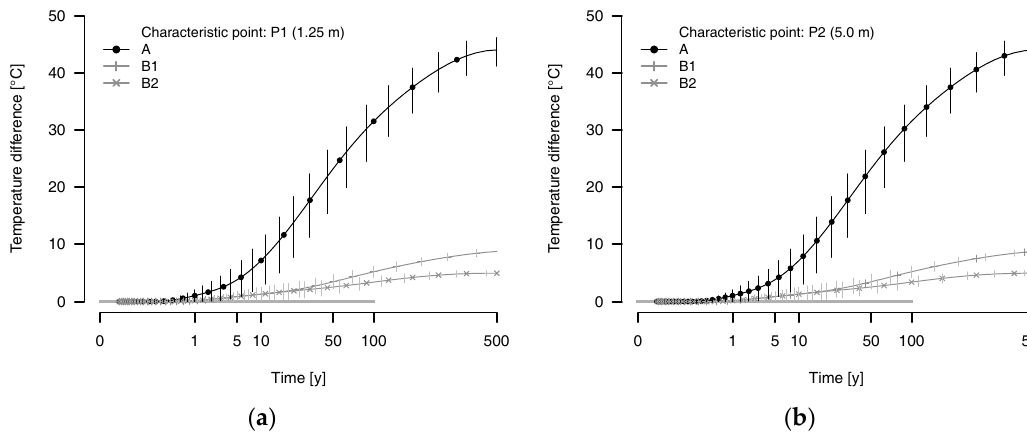
Figure 3. Temperature difference between the pilot field and main field in repository configurations case A, case B1, and case B2; ( a ) at P 1 ; ( b ) at P 2 .